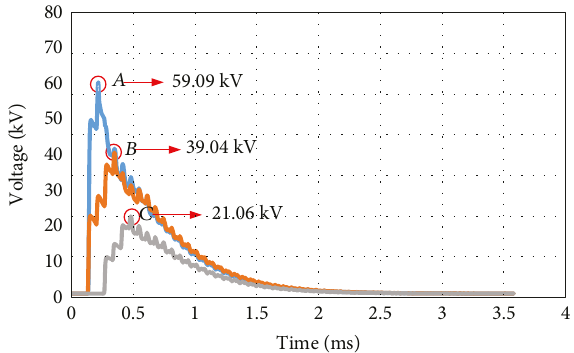
Figure 11: GPR at points A, B, and C after lightning in the irregular ground grid.